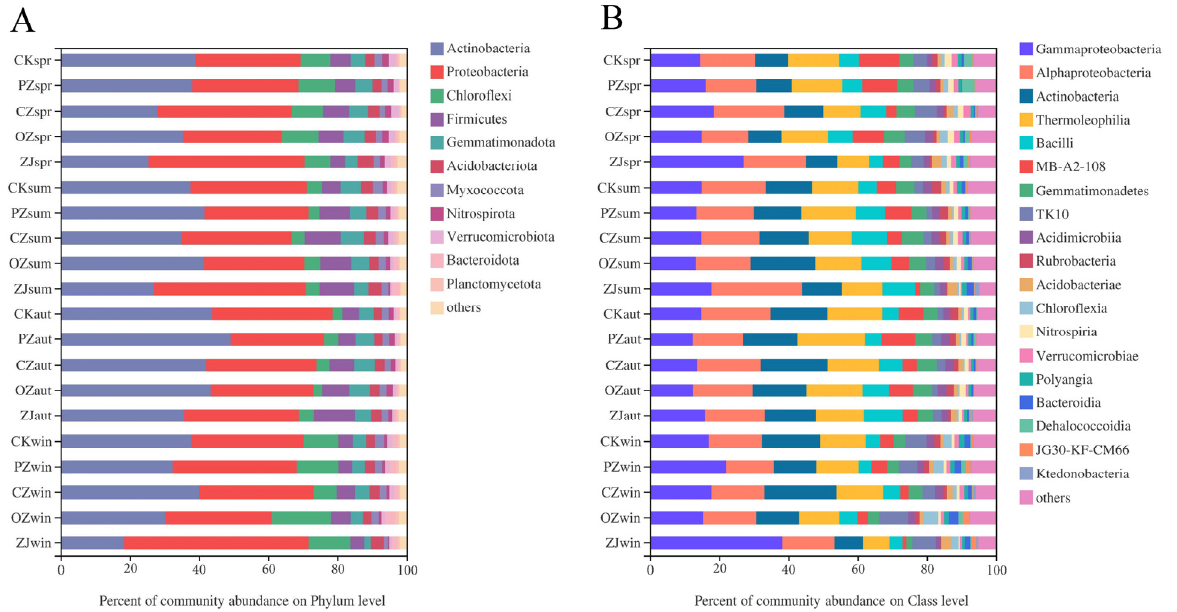
Figure 4. Relative abundances of soil bacterial community structure at phylum ( A ) and class ( B ) levels. CK: control; PZ: C . heterophylla ; CZ: C . kweichowensis ; OZ: C . avellane ; ZJ: C . heterophylla × C . avellane ; spr: spring; sum: summer; aut: autumn; win: winter.